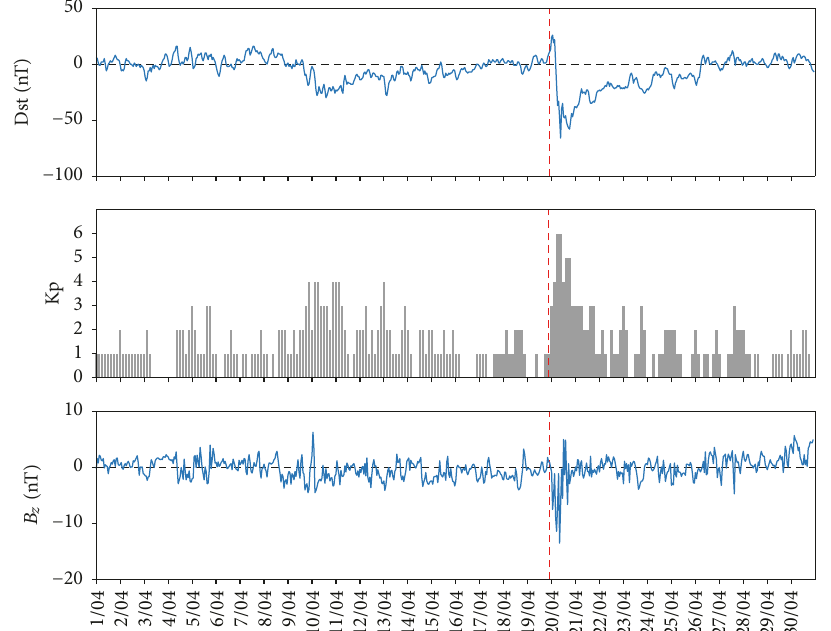
Figure 1: Dst and Kp geomagnetic indices during April 2018. Additionally, the vertical component of the interplanetary magnetic field ( 𝐵 𝑧 ) is shown. The vertical red dashed line indicates the storm sudden commencement